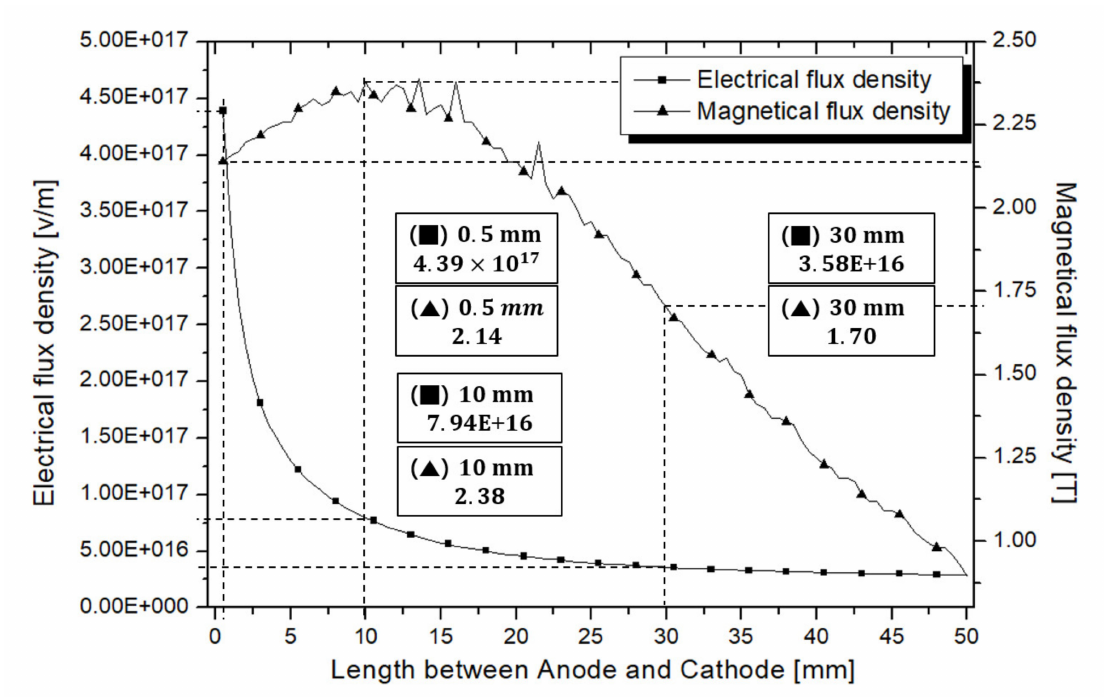
Figure 6. Electric field and magnetic field distributions according to the distance between